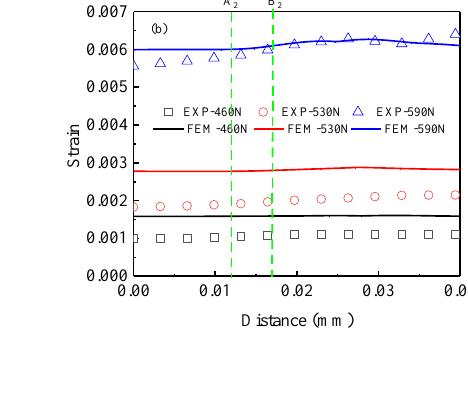
Figure 7. Strain evolution of special points with increasing load in the test: ( a ) region 1# ( b ) region 2#.